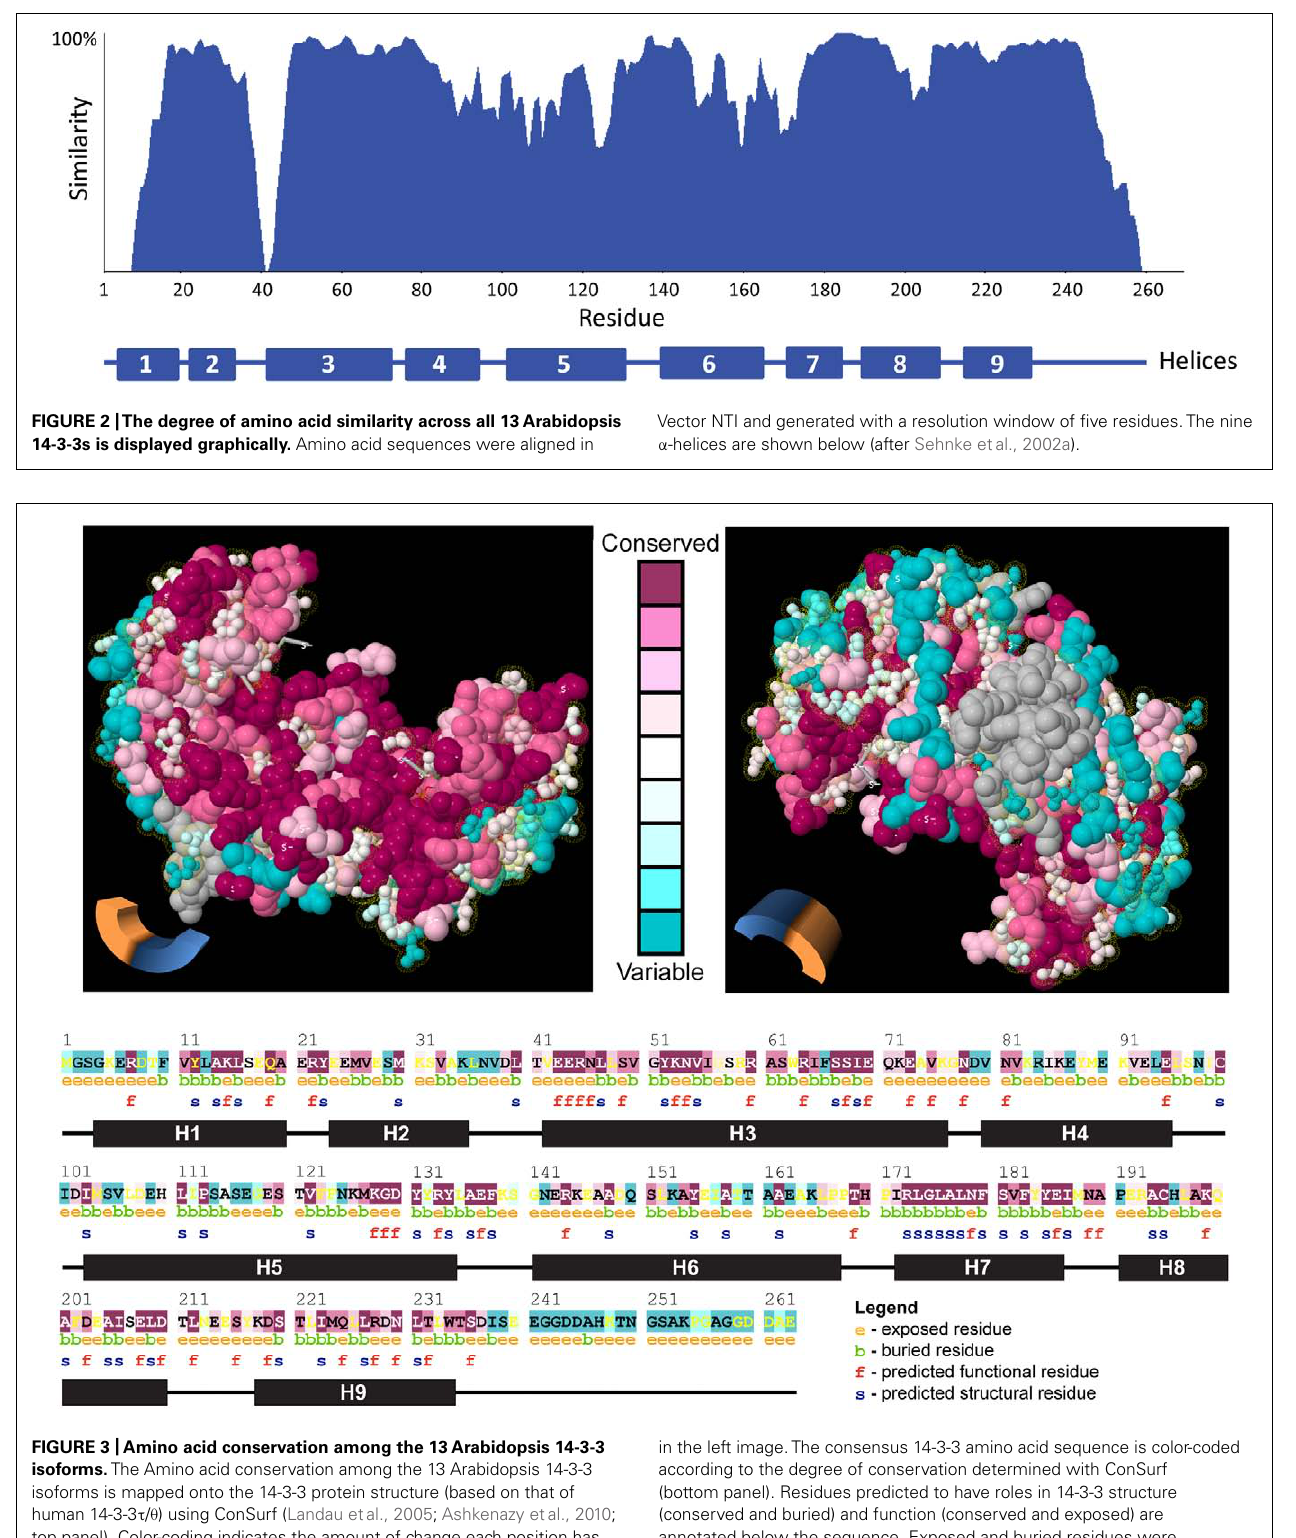
FIGURE 3 |Amino acid conservation among the 13Arabidopsis 14-3-3 isoforms. The Amino acid conservation among the 13 Arabidopsis 14-3-3 isoforms is mapped onto the 14-3-3 protein structure (based on that of human 14-3-3 τ / θ ) using ConSurf (Landau etal., 2005; Ashkenazy etal., 2010; top panel). Color-coding indicates the amount of change each position has undergone over evolutionary time.Views are angled with perspectives shown in lower left corners, with monomers in orange and blue. Residue conservation is highest in the client binding channel, which is exposed